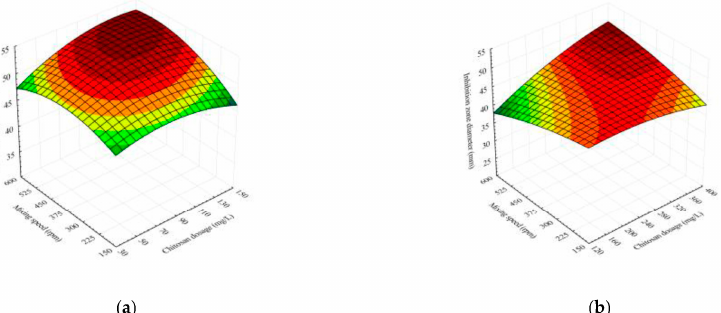
Figure 3. Response surface illustrating the interaction effects of factors on the inhibition zone diameter of Bacillus sp. BioSol021 after flocculation using chitosan in ( a ) cheese whey effluent and ( b ) winery flotation effluent.